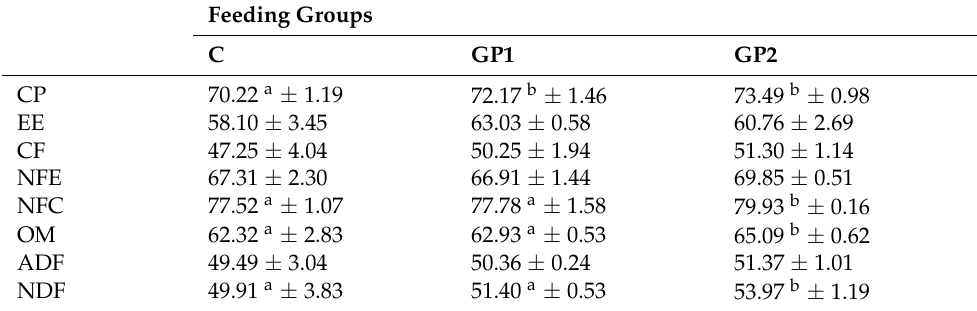
Table 4. Digestibility coefficients (%) of the different feeding